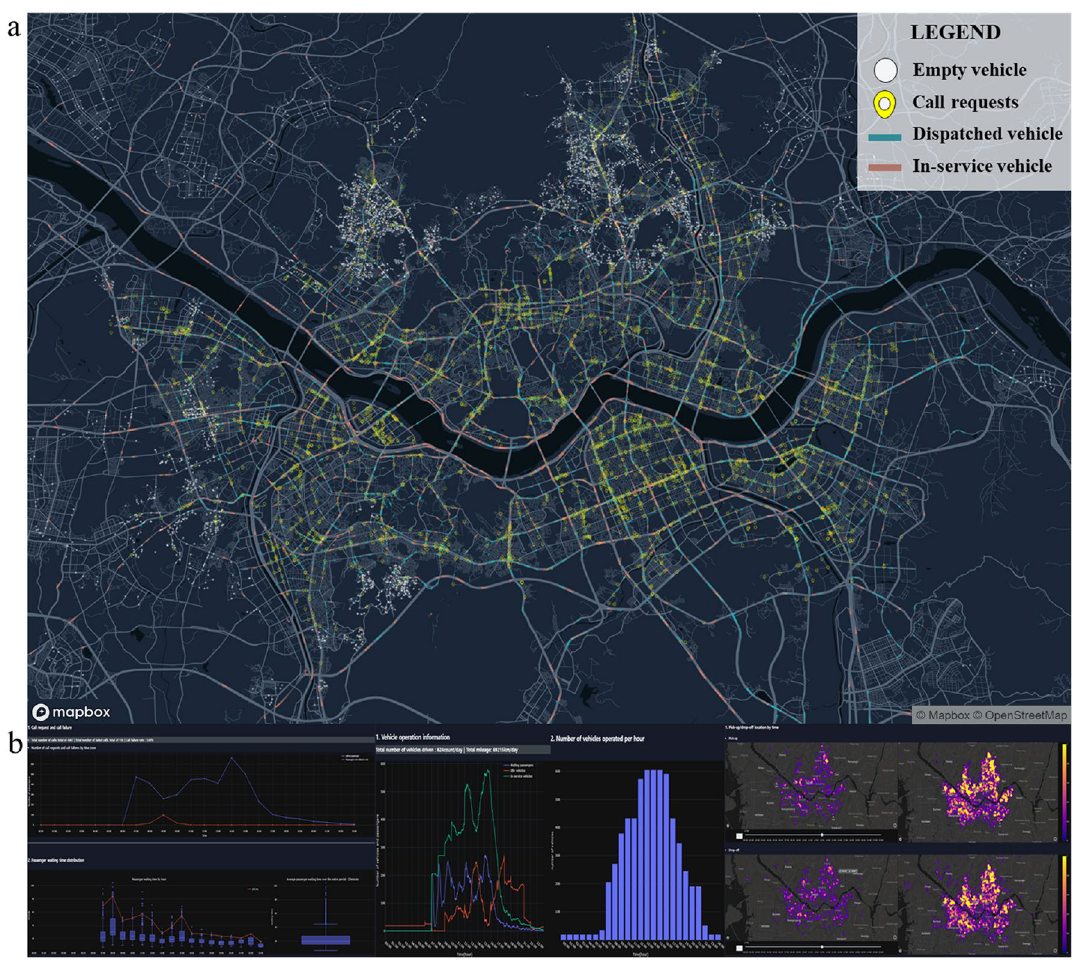
Figure 2. Final implementation of DTUMOS in Seoul Metropolitan Area. ( a ) a simulation visualization using deck.gl framework ( b ) a system performance report containing level of service (LOS) of the system, vehicle operation information, and spatial analysis. See a simul ation visua lizat ion and a syste m perfo rmanc e report in a web browser. The map is created using Mapbox GL JS v.2.12.0 (https:// www. mapbox.